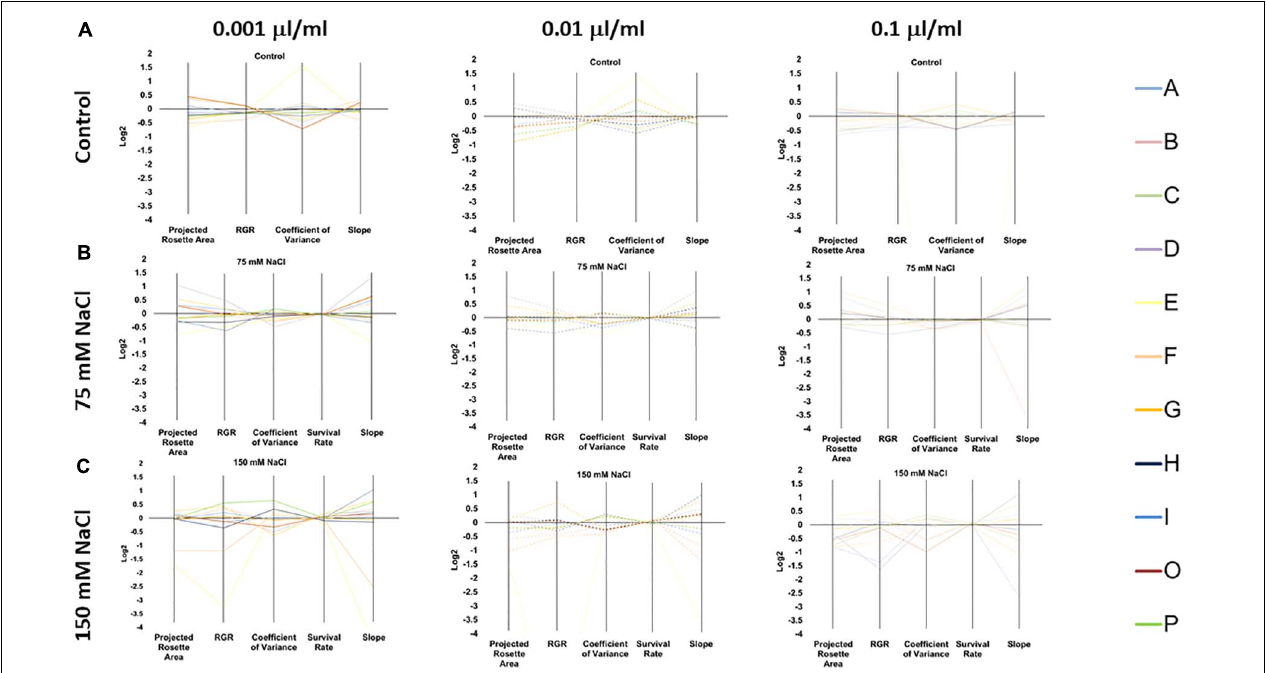
FIGURE 4 | Characterization of the 11 plant biostimulants. Parallel coordinate plot of the traits (Projected Rosette Area, Relative Growth Rate, Coefficient of Variance, Survival Rate, and Slope of the Growth Curve) obtained from the Multi-trait HTS of Arabidopsis seeds primed with the PHs at three concentrations (0.001, 0.01, and 0.1 µ l/ml) and grown under non-saline (A) 75 mM NaCl (B) , or 150 mM NaCl (C)